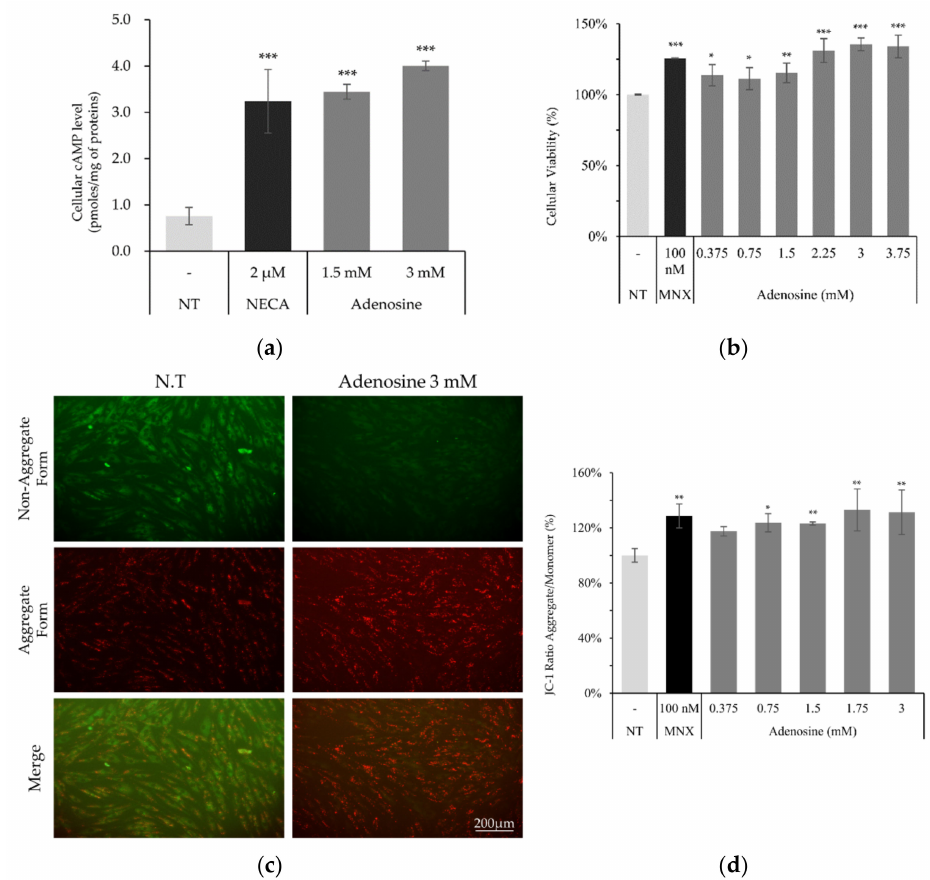
Figure 2. Adenosine enhanced cellular viability and mitochondrial energy metabolism in human dermal papilla cells. ( a ) Cellular cAMP level was increased by adenosine treatment for 2 min in hDPCs. ( b ) Cell viability measured by NADH/NADPH generation rates was enhanced by adenosine treatment for 4 h. ( c ) Mitochondrial membrane potential ( (cid:52) Ψ ) was measured after adenosine treatment for 4 h. ( d ) JC-1 monomer form was seen as green and aggregate form as red by fluorescent microscopy. Minoxidil was used as a positive control. The data represent the means of six independent samples. MNX, minoxidil; N.T, non-treated control; Significantly different compared with N.T (* p < 0.05, ** p < 0.01, *** p < 0.001).